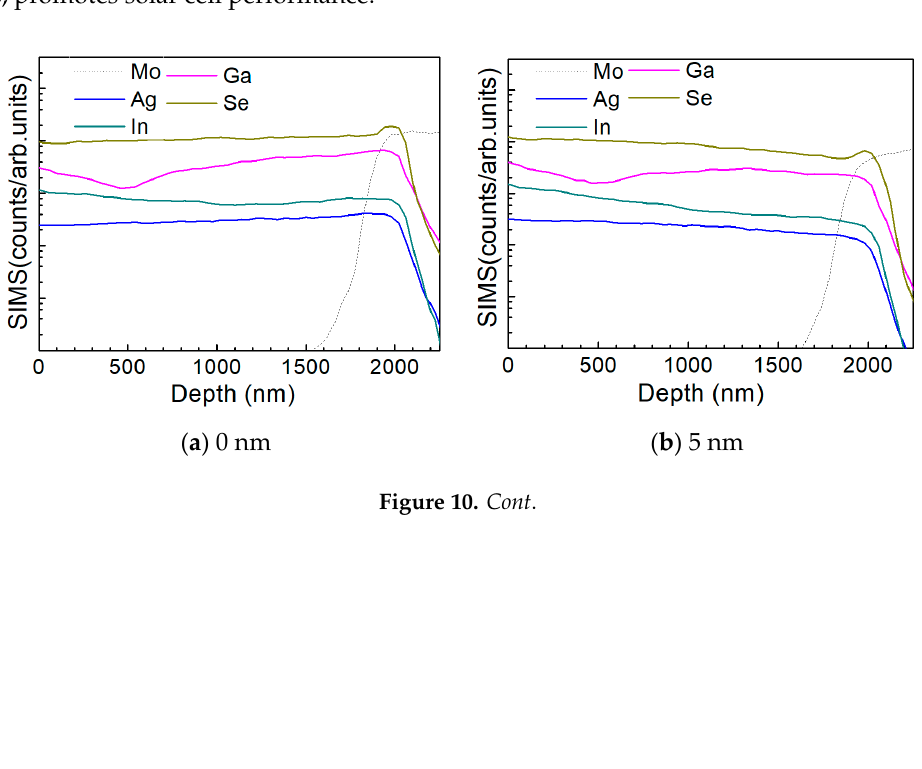
Figure 9. XRD patterns of AIGS films with different thicknesses of Na 2 Se.